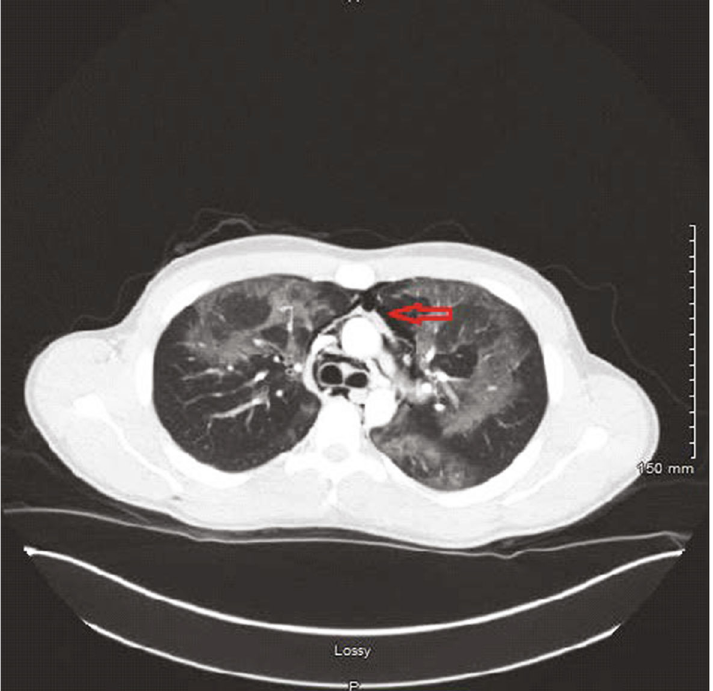
Figure 2: Computed tomography (CT) chest showing severe pneumomediastinum (red arrow) with di ff use